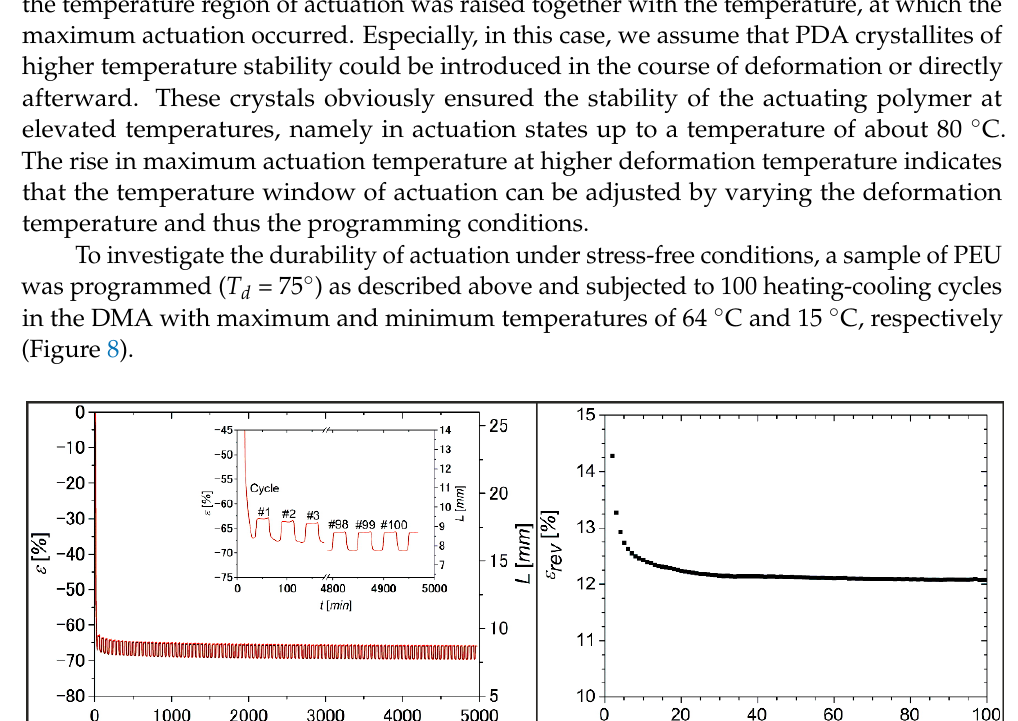
rev with cycle number